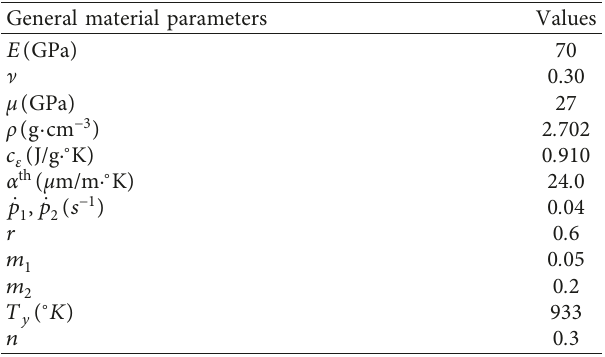
Table 1: General material parameters of aluminium for the current numerical simulations [15, 18].